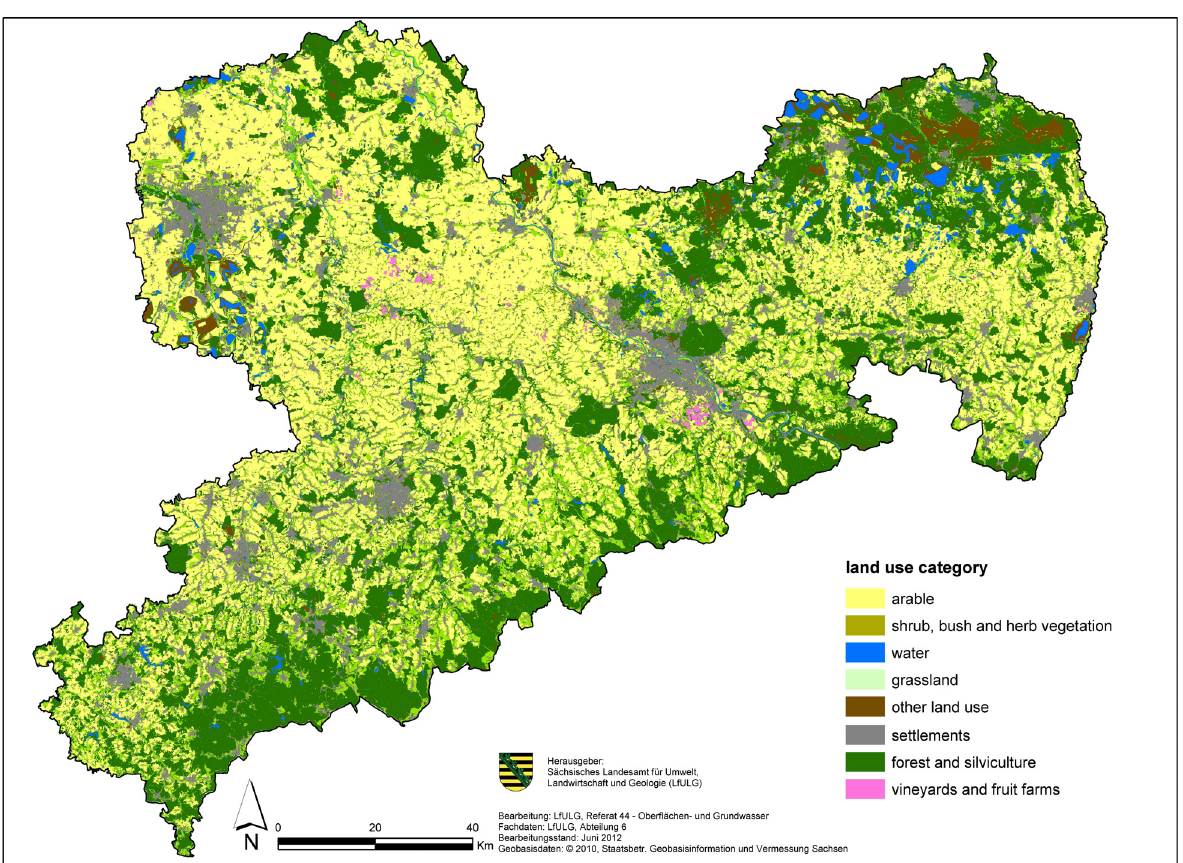
Figure 2. Land use in Saxony (based on aerial photographs from 2005/2006).